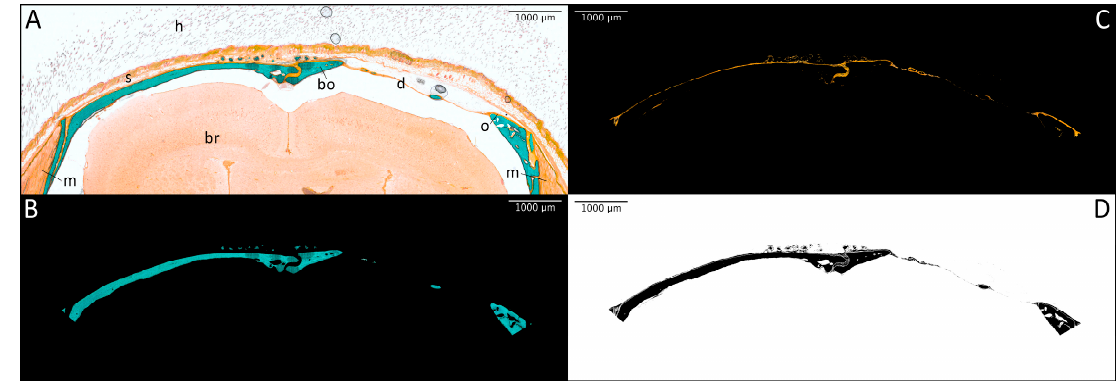
Figure 4. Laterolateral thin section of a mouse without an implant after trichrome-masson-goldner staining (( A ); bo = mineralised bone tissue, br = brain, d = defect, h = hair, m = muscle tissue, o = osteoid seam, s = skin; 10-fold magnification); mineralised bone tissue (turquoise) after thresholding ( B ); osteoid (orange) after thresholding and subtracting fibrotic and muscular tissue ( C ); double-thresholded total bone area (black = mineralised bone tissue + osteoid) ready for analysis ( D ).